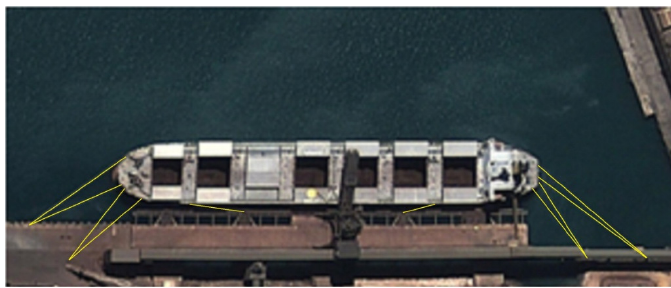
Figure 2. Panamax bulk carrier moored at Berth 5 with a typical mooring layout (mooring lines highlighted in yellow; spring lines and outer bow/stern lines are double; source: Google Earth).